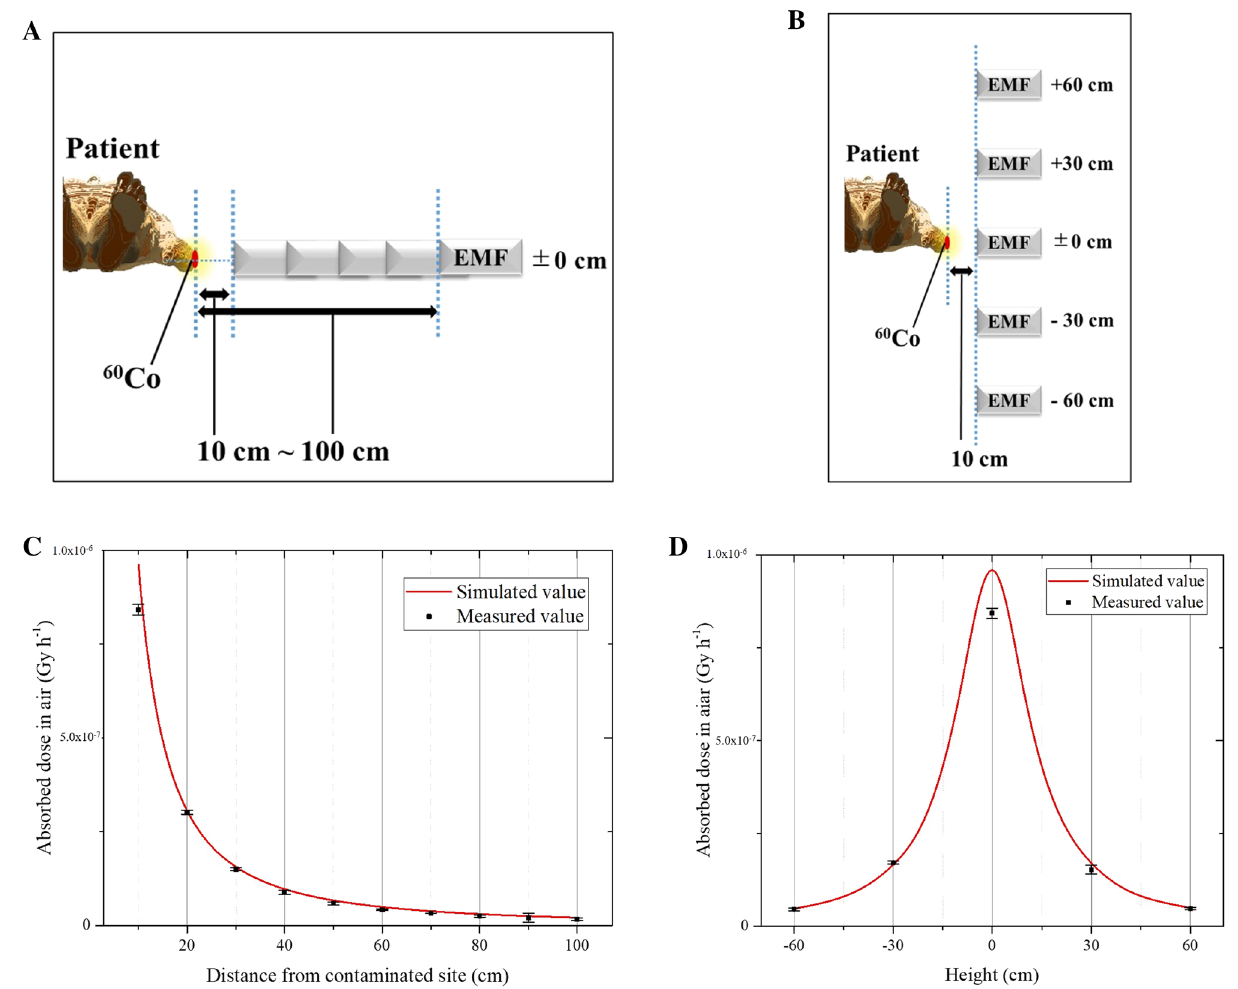
Figure 2. Verifying the accuracy of the simulation model. ( A ) The outline when the spectrometer was set at 10-cm intervals (10–100 cm) from the contaminated site. ( B ) The outline when the height of the spectrometer was changed to a distance of 10 cm from the contaminated site. ( C ) Comparing the measured and simulated values when the spectrometer was set at 10-cm intervals (10–100 cm) from the contaminated site and ( D ) when the height of the spectrometer was changed to a distance of 10 cm from the contaminated